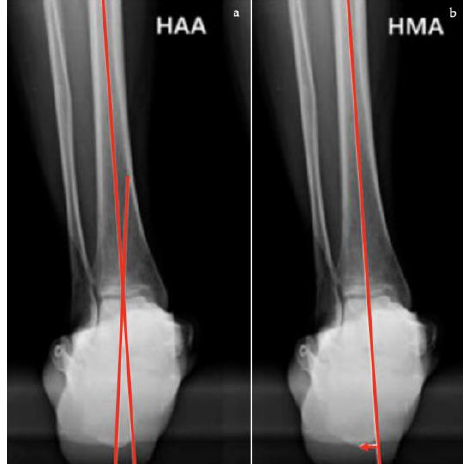
Figure 9. Saltzman view. ( a ) Hindfoot Alignment Angle (HAA) (formed by the intersection of the longitudinal axis of the tibial shaft and the axis of the calcaneal tuberosity). ( b ) Hindfoot Moment Arm (measured by the shortest distance between the midtibial axis and the most inferior portion of the calcaneus gus, represented by the red arrow).